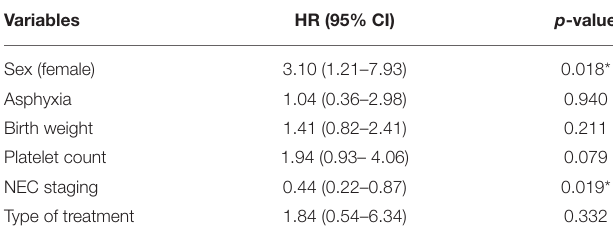
TABLE 3 | Multivariate analysis of survival of neonates with NEC in our